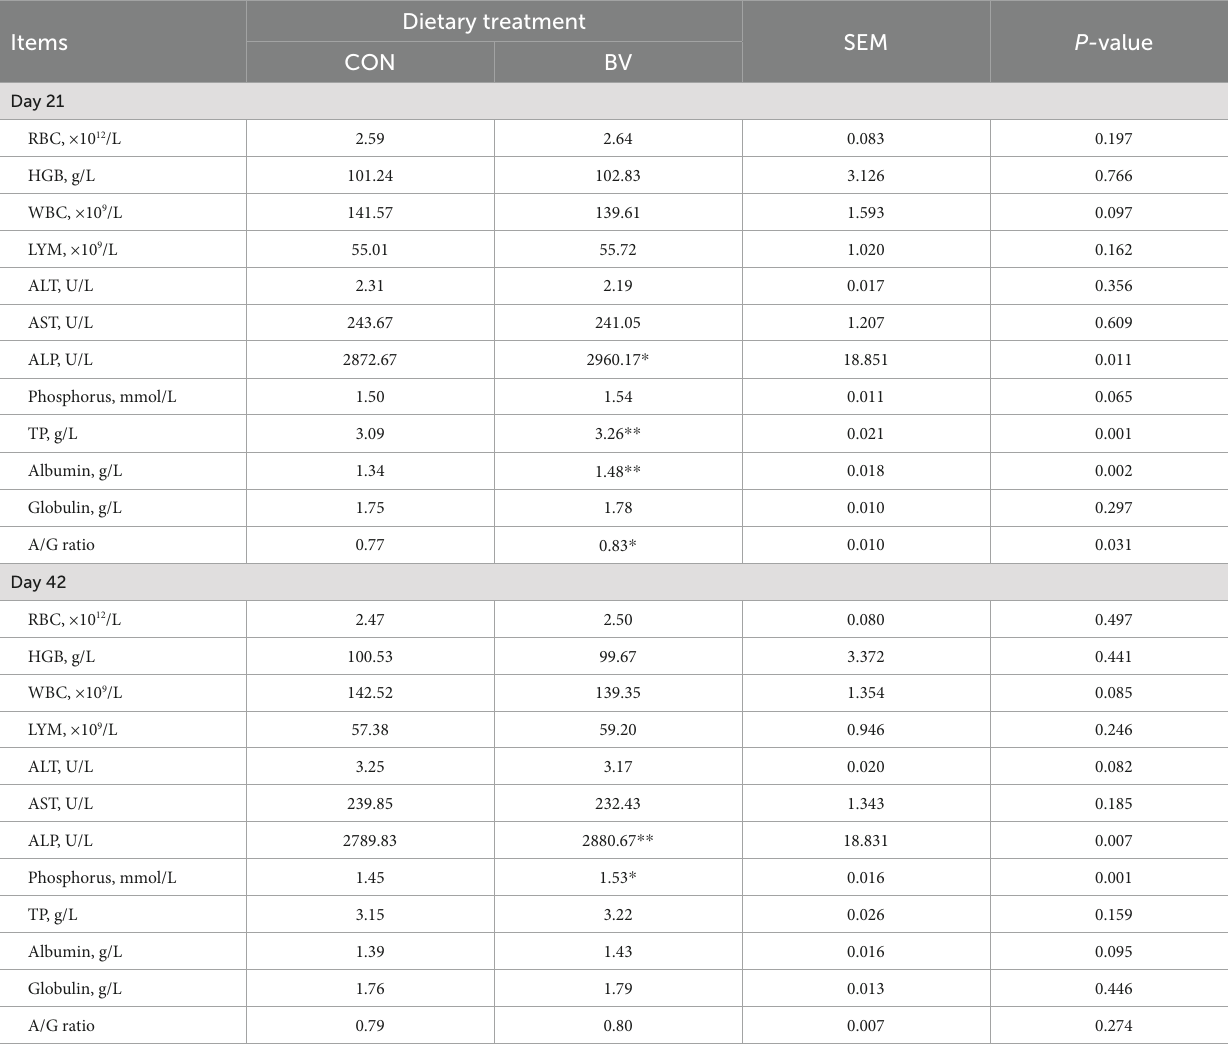
TABLE 3 Effect of Bacillus velezensis LB-Y-1 on hematological and serum biochemical indexes of broilers ( n = 6). Dietary treatment Items